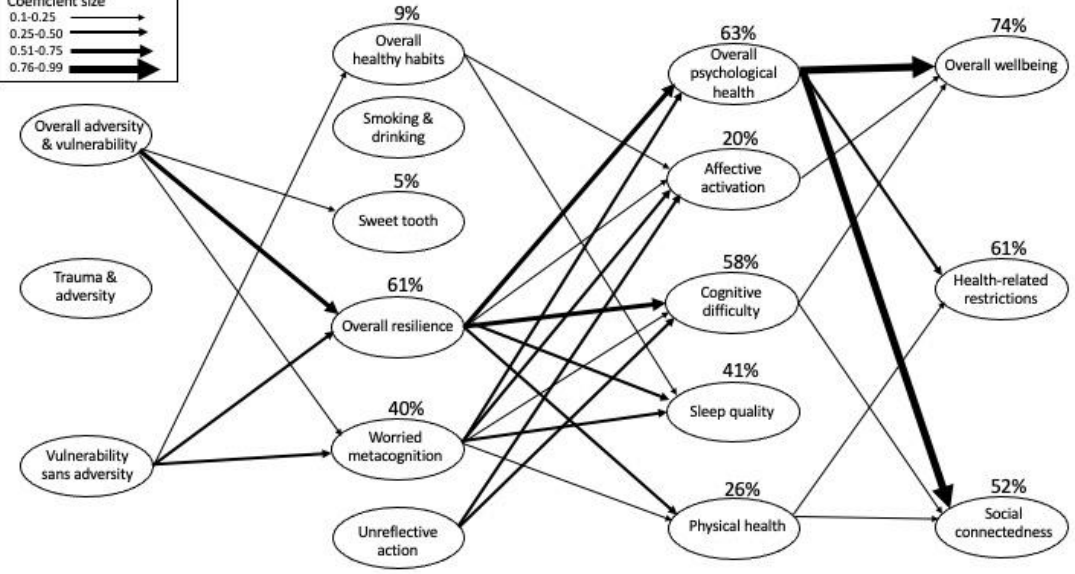
Figure 1. Pathways across domains identified by multiple regressions; percent figures indicate variance accounted for (R 2 of the multiple regression solution) by factors in the previous domain.